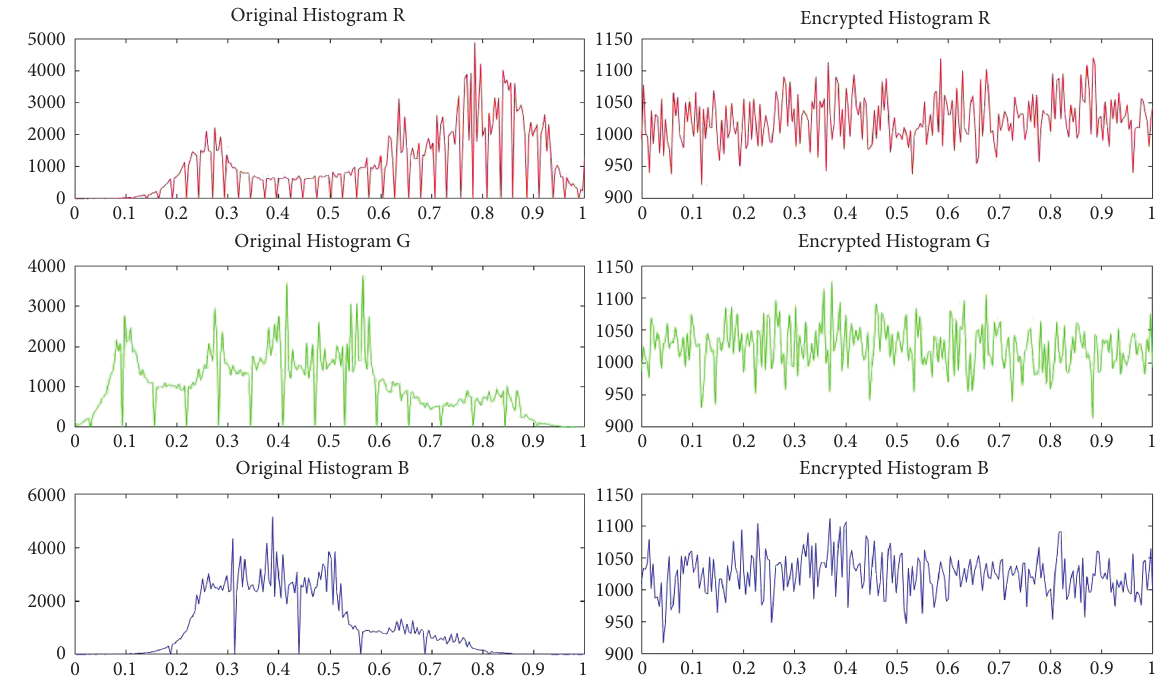
Figure 10: RGB color histogram of original “Lena” image and its corresponding cipher image. Table 3: Variance of histogram for encrypted grayscale images.